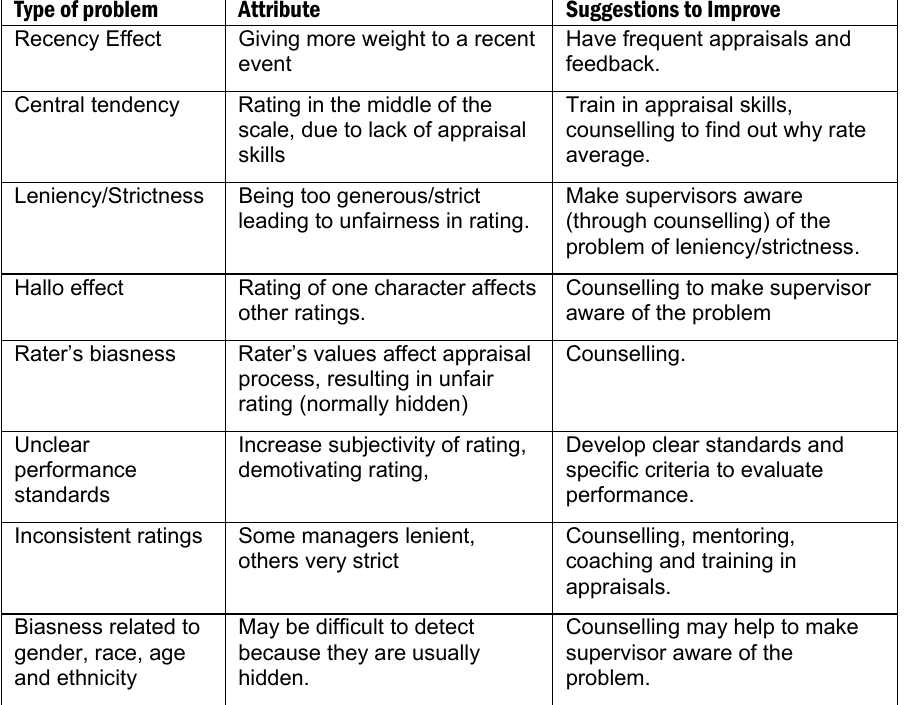
Table 2: Performance Appraisal